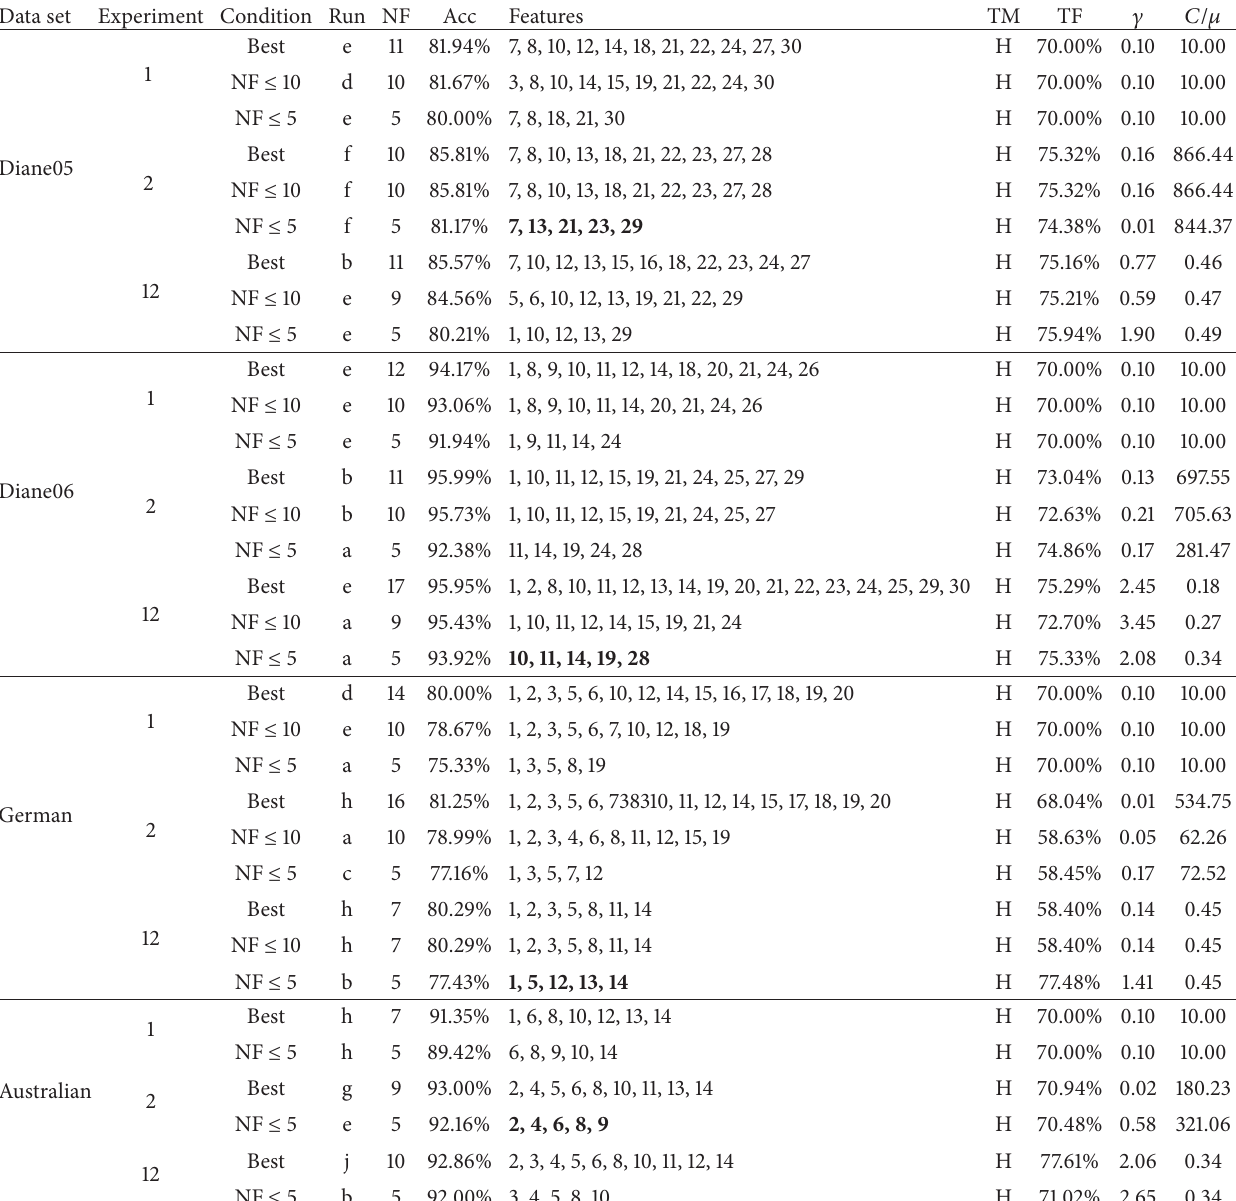
Table 6: Results summary for Experiments 1, 2, and 12 and for all